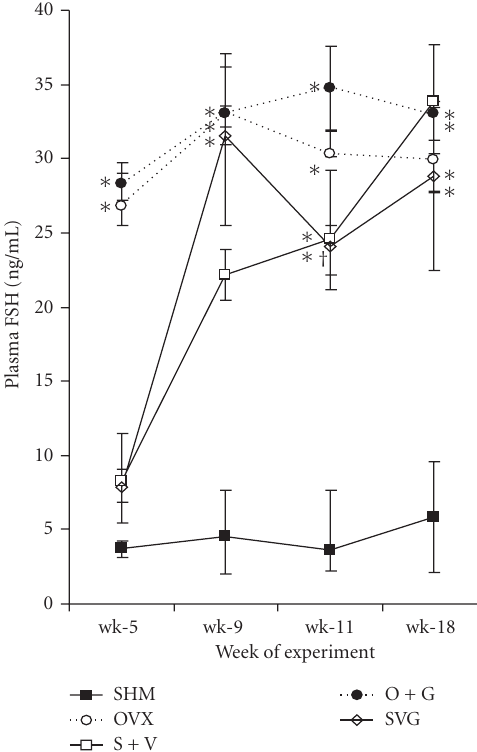
Figure 6: Comparisons of plasma FSH among groups of mice. One-way ANOVAs performed at each time period were significant ( P < . 0001). Values represent means ± SEM. Di ff erent symbols signify di ff erences among groups based on the Tukey-Kramer post hoc procedure as follows: ∗ SHM < all other groups; † VCD-treated mice < OVX groups; § S + V < OVX groups; ‡ SVG < O +